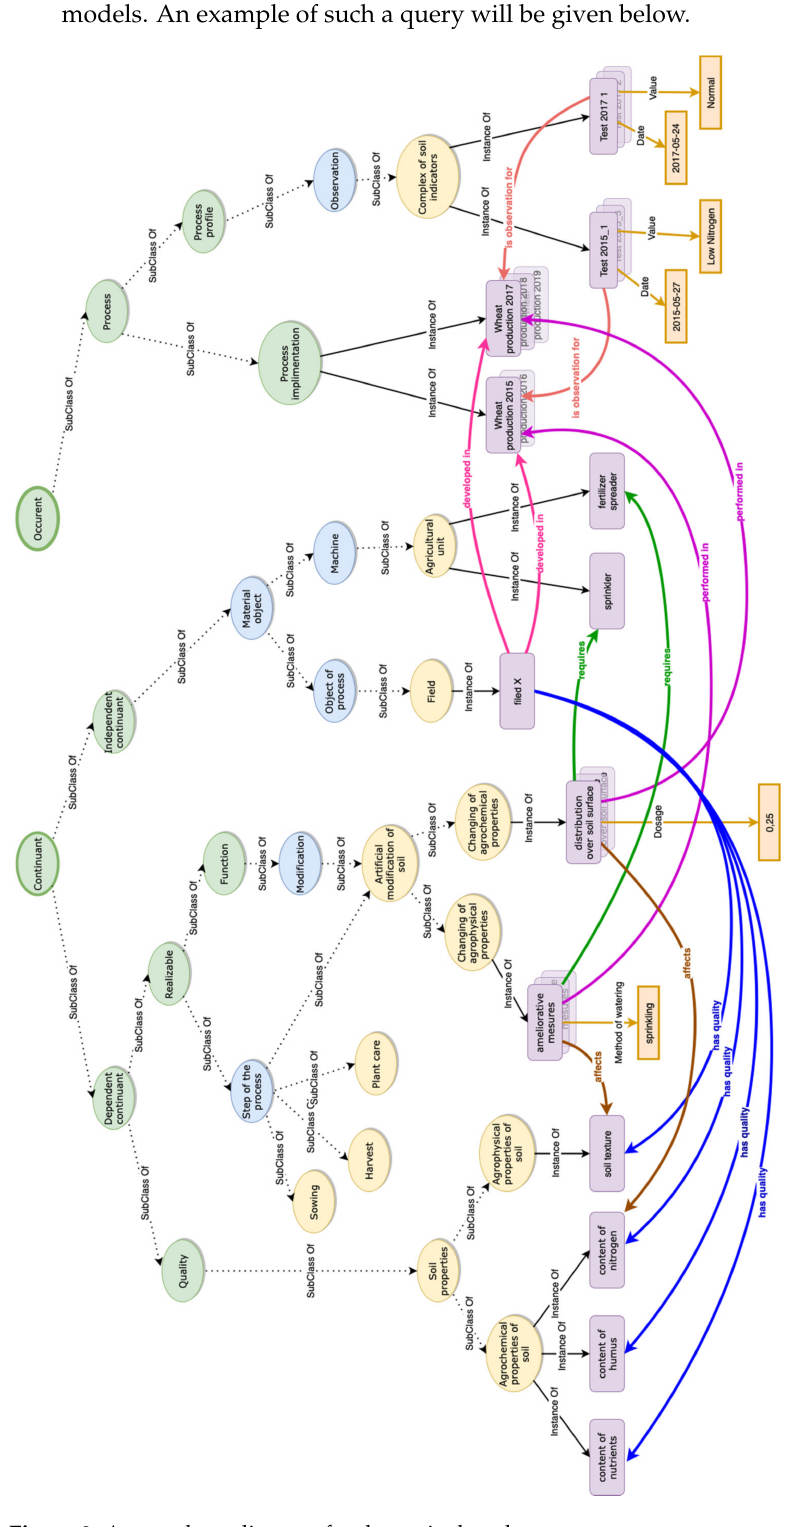
Figure 3. An ontology diagram for the agricultural